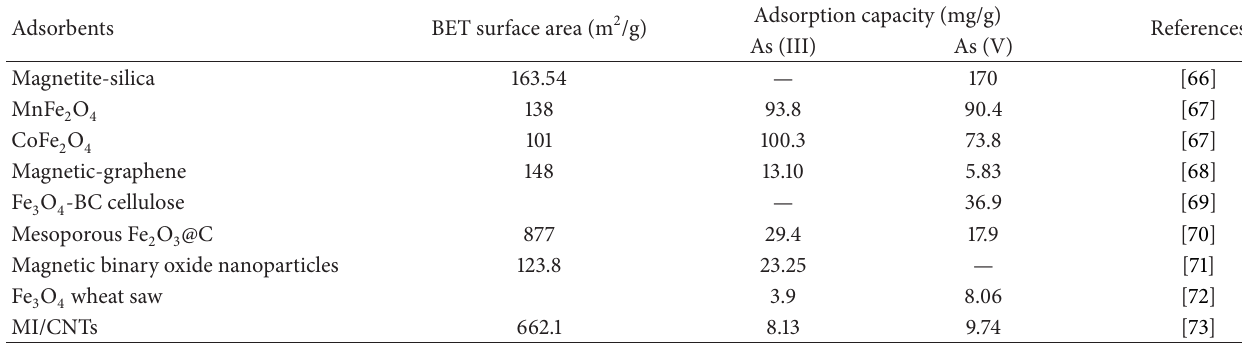
Table 3: Overview of various iron oxide nanomaterials for removal of